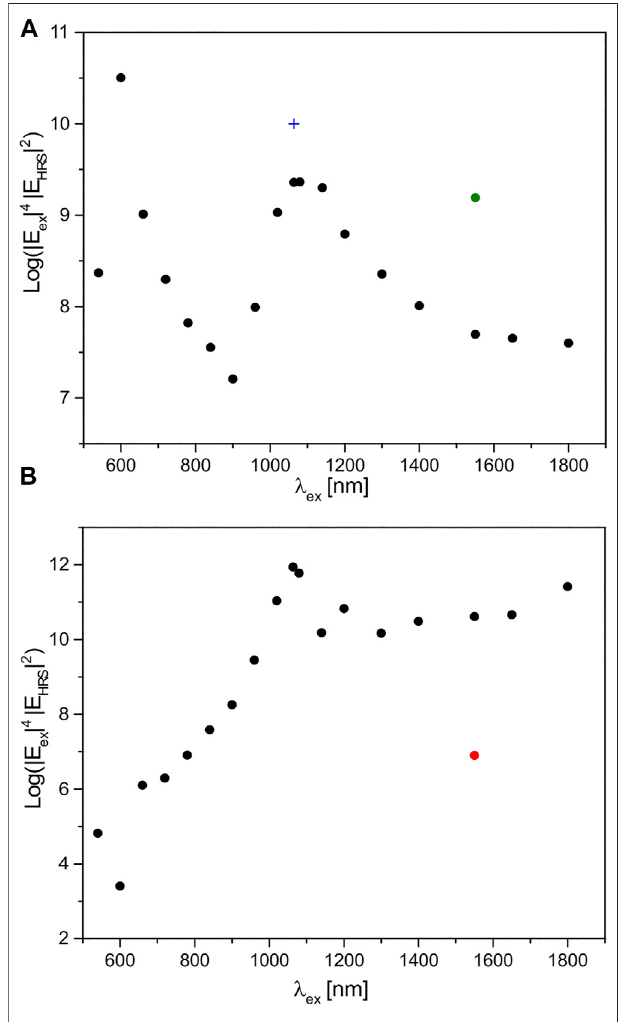
FIGURE 1 | Maximum SEHRS enhancement, as a function of excitation wavelength, as a result of 3D FDTD simulations in an aqueous environment of a dimer (A) of gold nanospheres of a diameter of 44 nm and (B) of gold nanorods with a length of 80 nm and a thickness of 16 nm. The maximum enhancement was determined in a 2D map of the SEHRS intensity in the equatorial plane of the 3D structure. The gap between the particles is 2 nm. The propagation of the incident plane wave is in z direction, and it is polarized along the long axis of the dimers (cf. Figure 3 or Figure 4 ). The green dot in (A) indicates the SEHRS enhancement of a dimer of gold nanospheres with a diameter of 70 nm, corresponding to the geometry of nanospheres in the experiments reported in ref. (Heiner et al., 2021). The blue cross in (A) marks the SEHRS enhancement of a dimer of gold nanospheres with a diameter of 60 nm diameter reported by ref. (Madzharova et al., 2018). The red dot in (B) indicates the maximum SEHRS enhancement obtained in the simulation using a single gold nanorod of the same dimensions instead of thenanoroddimer.TheSEHRSenhancementistheproductofthenormalized electric fi eld intensity at the excitation wavelength and the respective Stokes HRS wavelengths chosen here to correspond to a molecular vibration with a wavenumber of 1,586 cm − 1